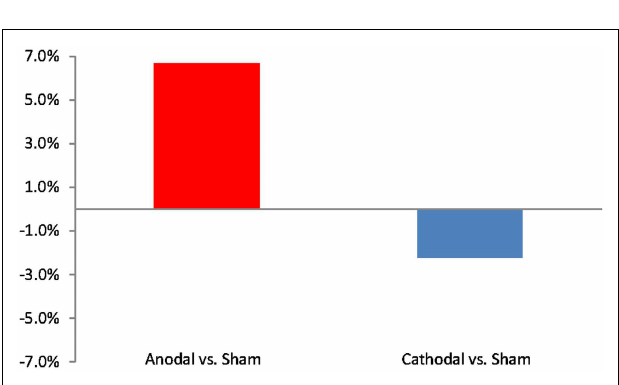
FIGURE 2 | Effects of active stimulation conditions compared to sham stimulation with respect to the percent words in clusters during a category-cued fluency